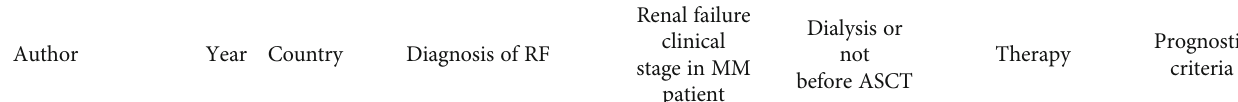
Table 1: ASCT in myeloma patients with renal insu ffi ciency, the characteristics of the